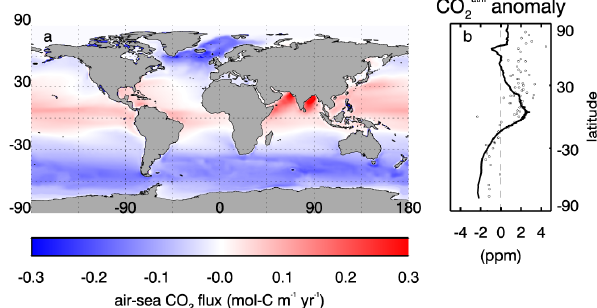
Fig. 5. Average air-sea CO 2 flux simulated during the first year after moving from the model ocean seeing a spatially and temporally ho- mogeneous CO atm concentration of 286ppm to seeing annual mean 2 (i.e. without a seasonal cycle) CO atm simulated interactively by the 2 HadGEM2-ES model, but still with a global mean of 286ppmv (left). The latitudinal variability in annually averaged CO atm cal- 2 culated for the pre-industrial by the fully coupled HadGEM2-ES model (solid line), and observations (dots) presented as an anomaly from the globally averaged CO atm during that model or observa- 2 tional year (right).